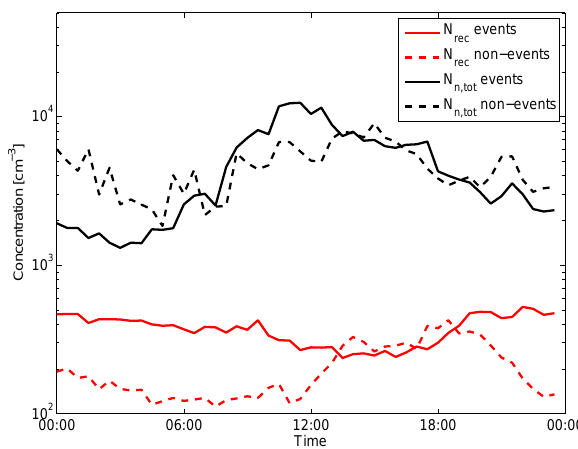
Fig. 5. The median diurnal variations of the concentrations of re- combination products ( N rec ) and all neutral clusters ( N n , tot ) in the size range of 0.9–2.1nm on new particle formation event and non- event